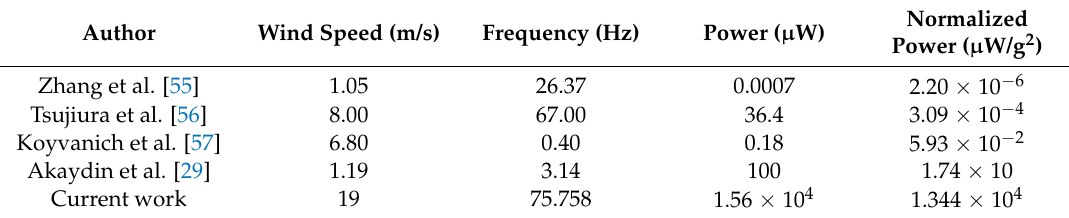
Table 5. Comparison of current study to other research results.